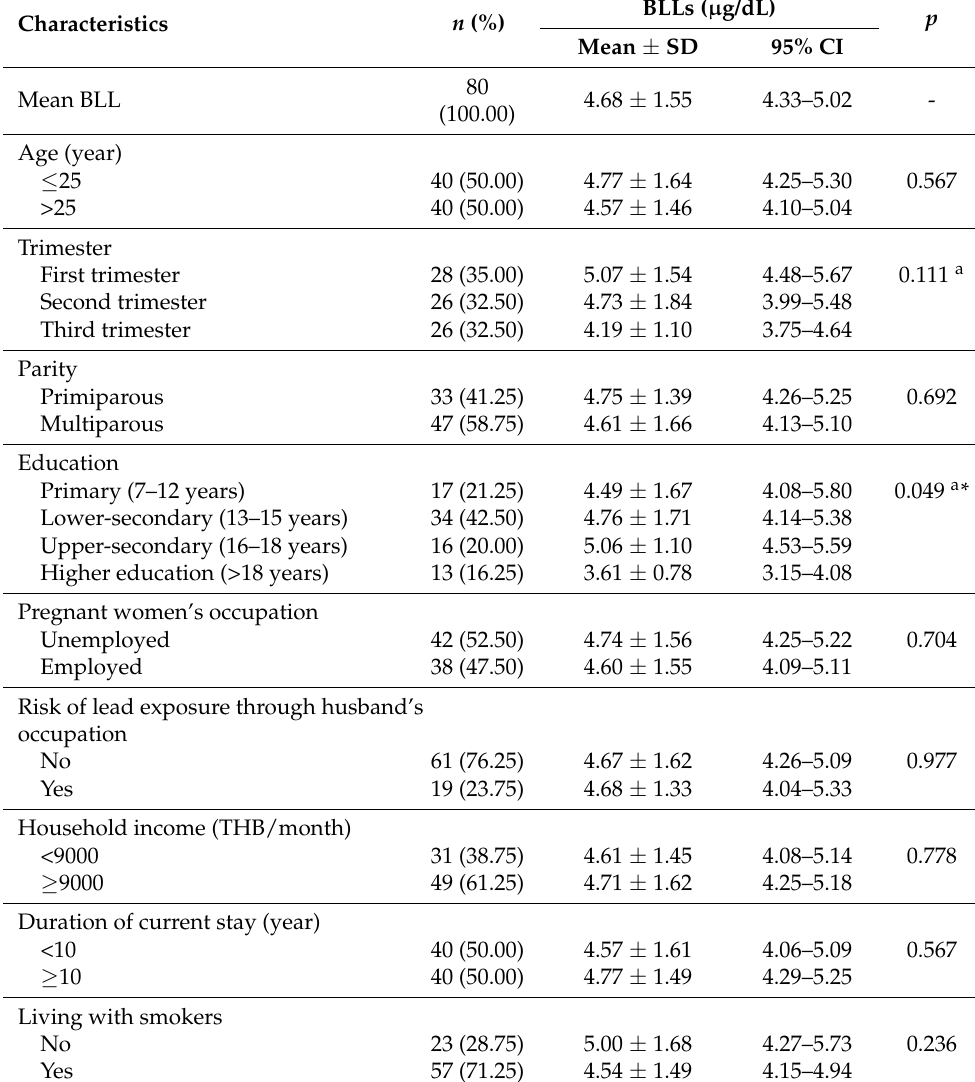
Table 1. Demographic characteristics and mean BLLs of pregnant women ( n =